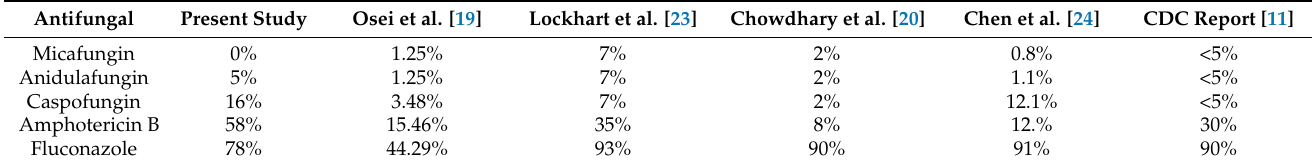
Table 6. Comparison table of resistance patterns for C. auris (% of